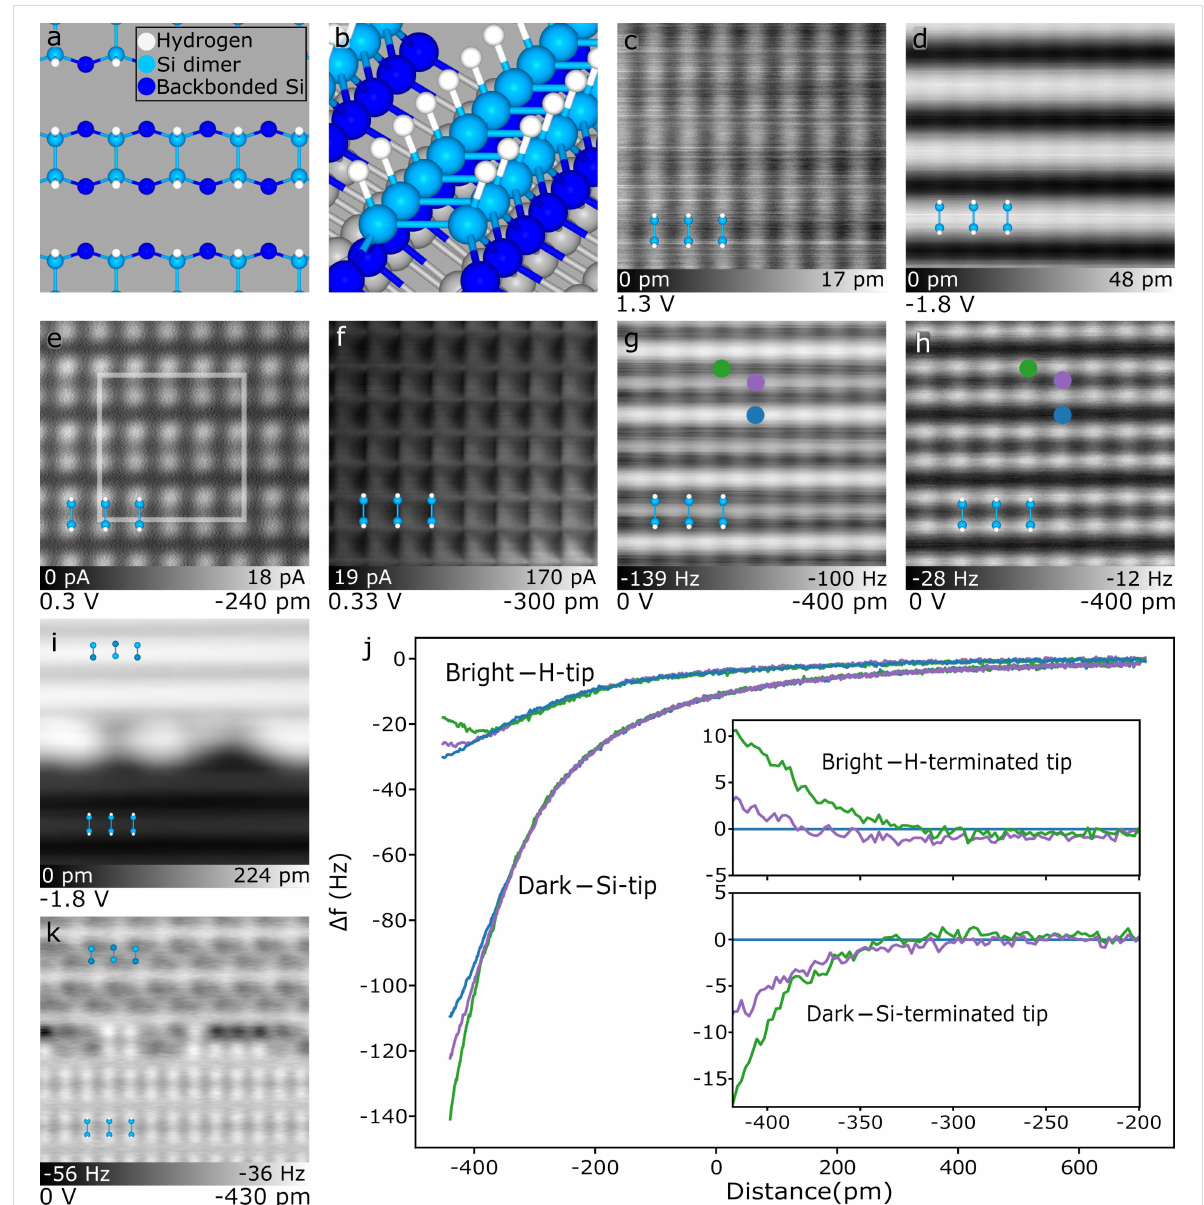
Figure 1: Surface of H-terminated Si(100)-2 × 1 in different imaging modes. (a,b) Top and isometric projection of a structural model of the H-termi- nated Si(100)-2 × 1 surface. The size of the area shown in (a) is outlined in (e). (c,d) Constant current ( I = 50 pA) STM topography probing empty and filled states of the surface (bias voltages indicated in the lower left of each panel). (e) Constant height STM image with a fixed bias and height. (f) Scanning tunnelling hydrogen microscopy image of the surface. (g) nc-AFM frequency shift map using a Si-functionalized tip that displays the hydrogen atoms in “dark contrast”. (h) nc-AFM frequency shift map measured with a H-functionalized tip showing hydrogen atoms in “bright contrast”. Images (c–h) are all 3.2 × 3.2 nm 2 , the indicated height offset ( Δ z at the bottom right of relevant panels) is initialized referencing a STM tunnelling setpoint of I = 50 pA and V = − 1.8 V over a H–Si surface atom. (i) Constant current STM topography of a half hydrogen-terminated (bottom) half unter- minated silicon (top) surface (5 × 5 nm 2 , V = − 1.8 V, I = 50 pA). (j) Position-dependent frequency shift spectroscopy Δ f ( z ) in bright and dark nc-AFM modes (positions indicated in (g) and (h)), highlighting the quantitative differences in tip reactivity for different apex terminations. The insets show the calculated difference spectra in reference to the spectra taken between the dimer rows (blue position marker). (k) AFM image of the same area